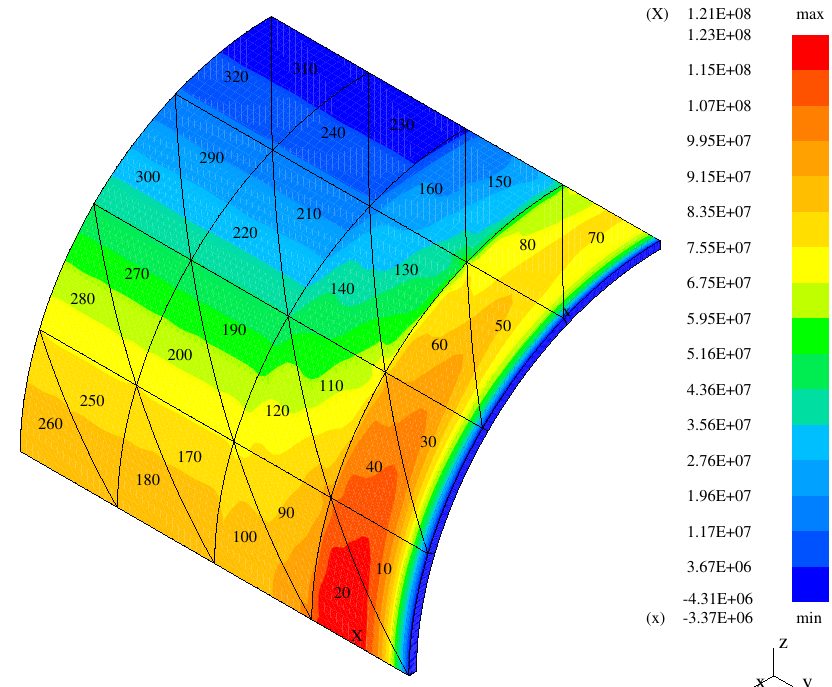
Figure 19. Third normal stress—the membrane with the enhanced transition